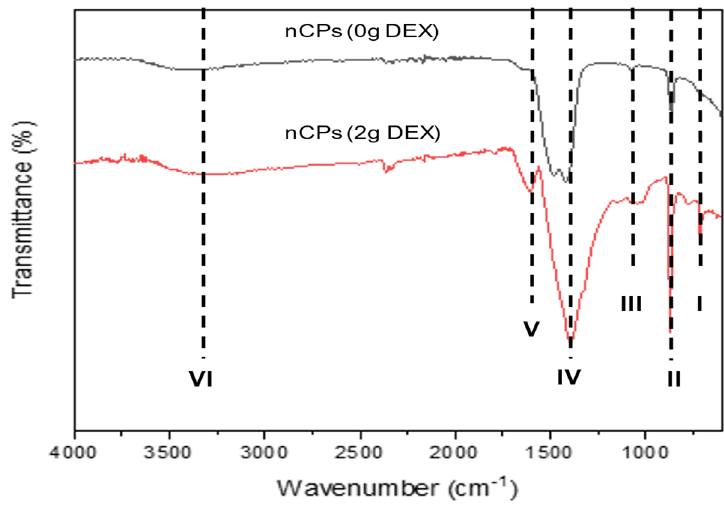
Figure 4. FTIR of nCPs (0gDEX) and nCPs (2gDEX).